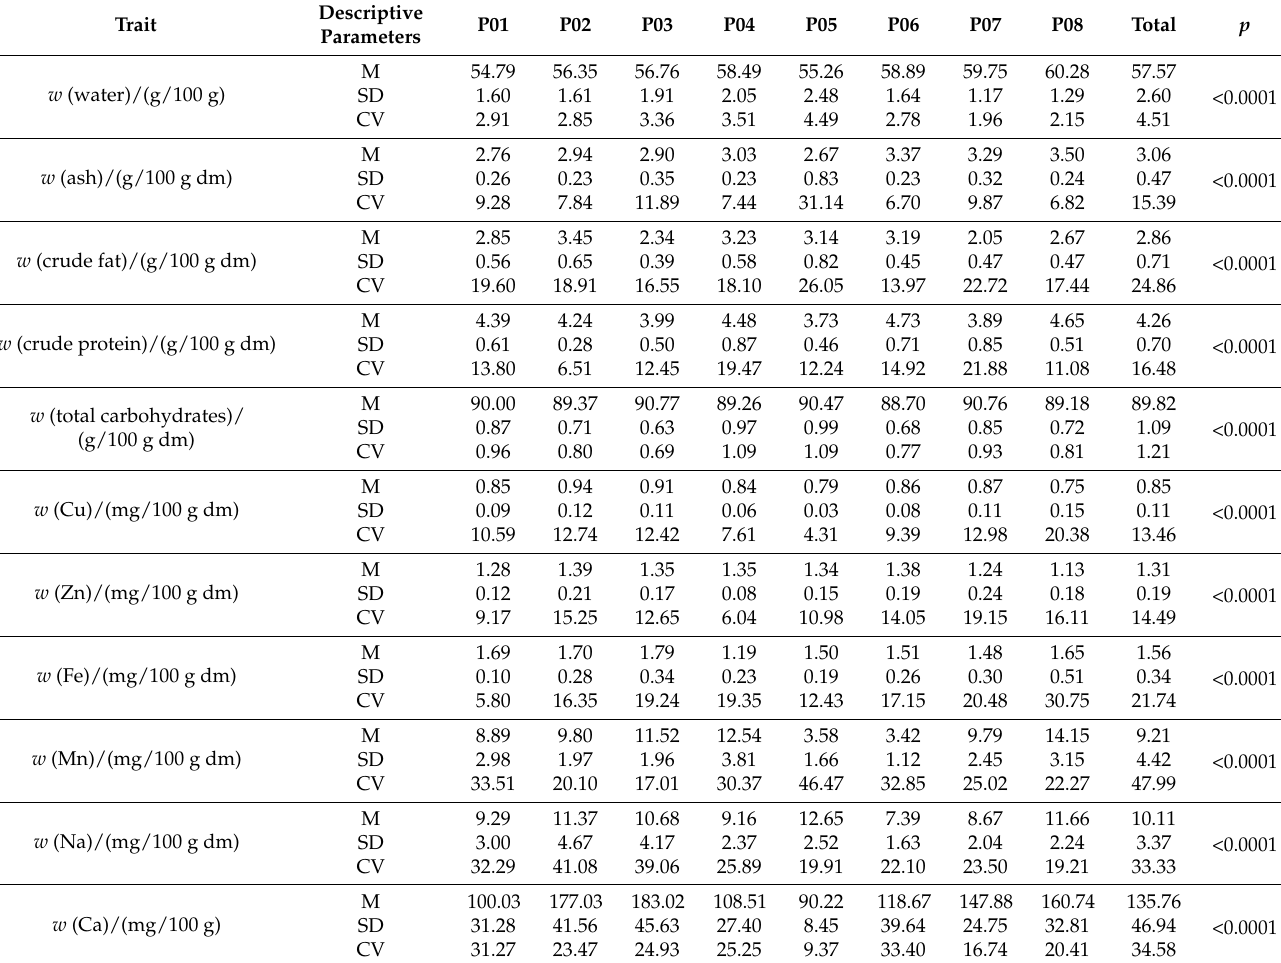
Table 4. Descriptive statistical parameters and level of significance for studied chemical